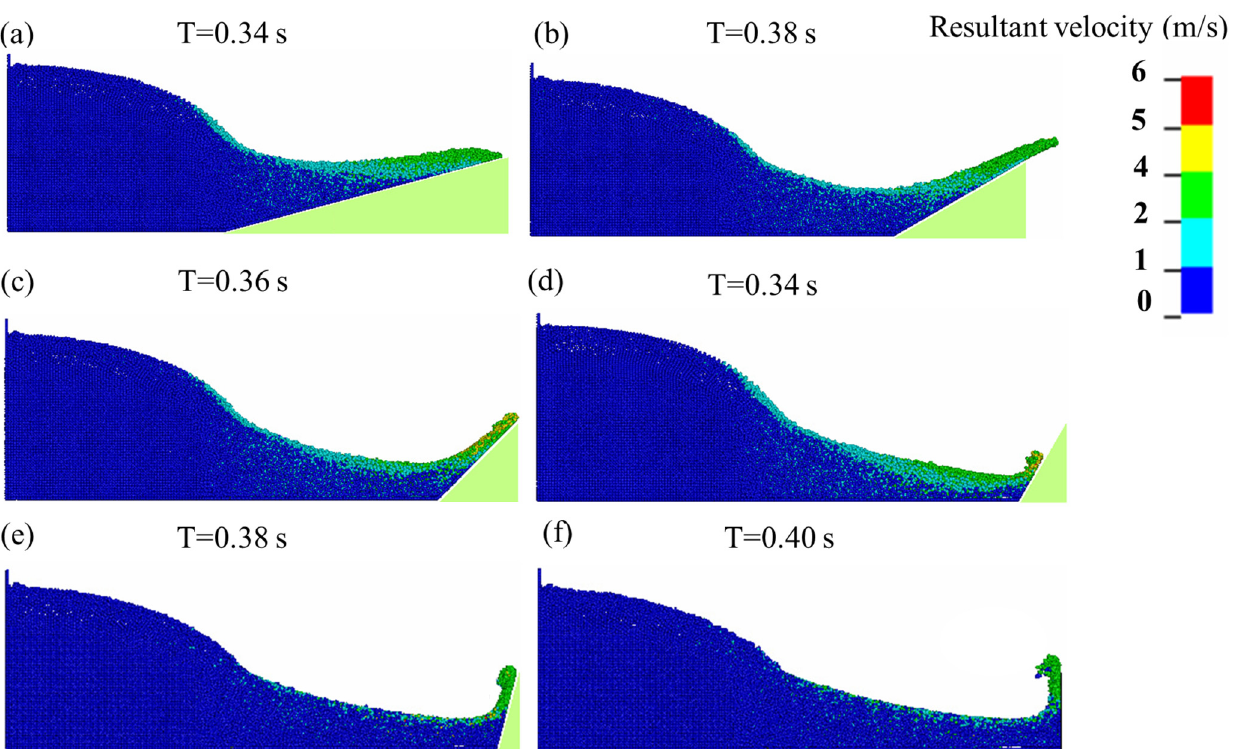
Figure 6. Flow states of the tailings particles when the catch dam’s upstream slope starts to be more or less fully covered by tailings slurry, with the inclination angles α varying from 15° to 90°: ( a ) 15°; ( b ) 30°; ( c ) 45°; ( d ) 60°; ( e ) 75°; ( f ) 90°.